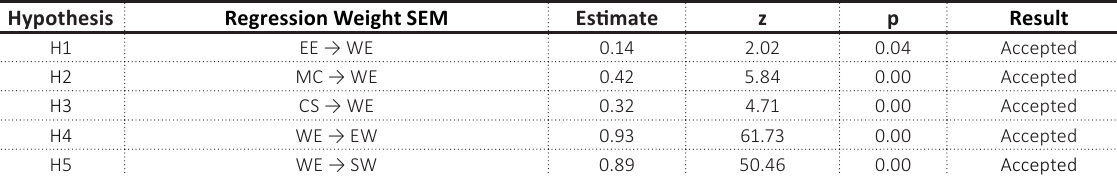
Table 3. Regression weight structural equation modeling